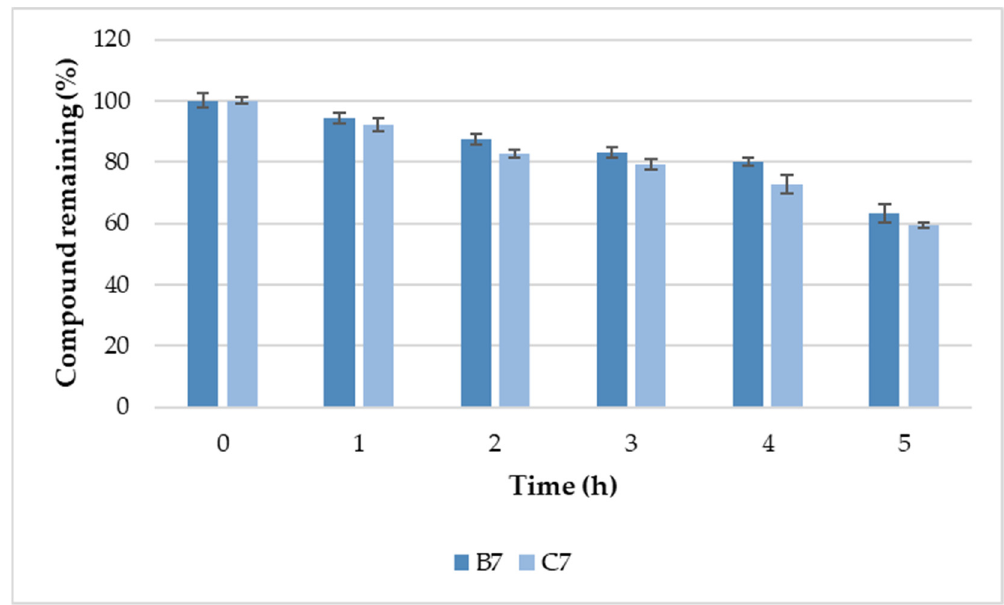
Figure 12. Minimum inhibitory concentrations (MICs) of selected componds in 10% ( v / v ) normal human serum.